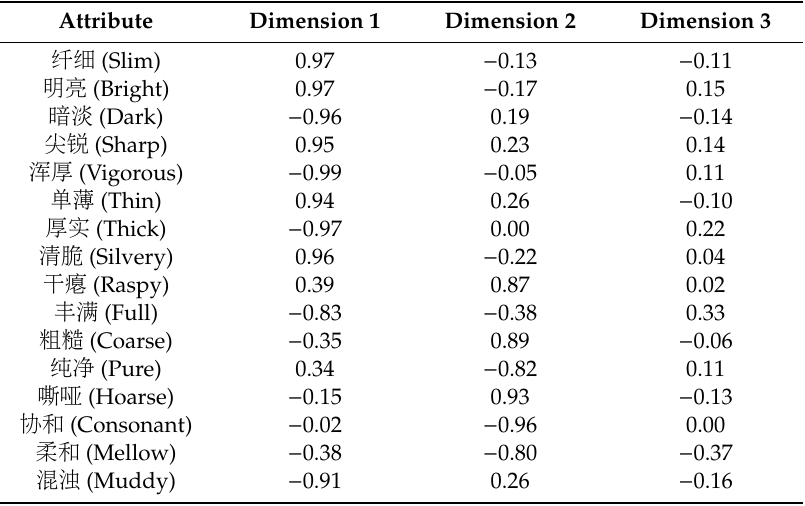
Table 8. The results of correlation analysis in 3D timbre space. Attribute Dimension 1 Dimension